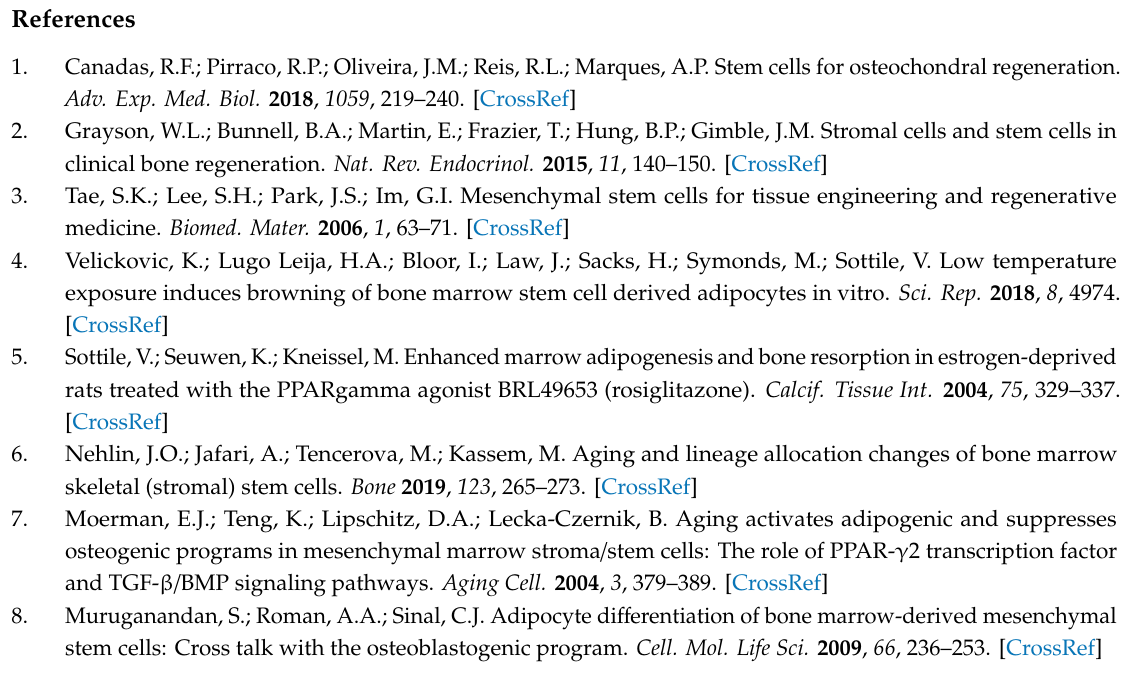
Figure S1: Metabolic activity assay carried out at day 25. VideoS1: 3D reconstruction of confocal analysis of DM-treated cells after TC, BD, HT labelling at endpoint. VideoS2: 3D reconstruction of confocal analysis under similar conditions, imaged at a higher